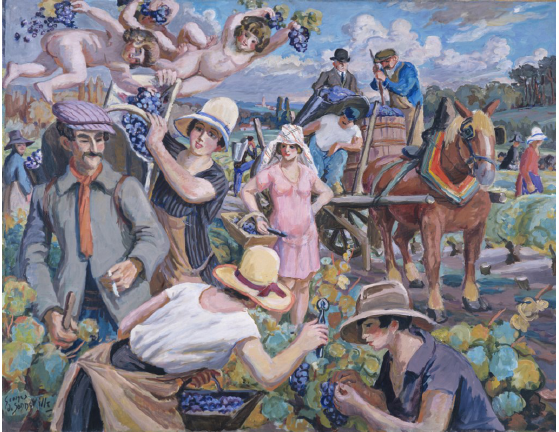
Figure 12. Georges Préveraud de Sonneville (1889–1978), Vendanges à Martillac , 1927, oil on canvas,